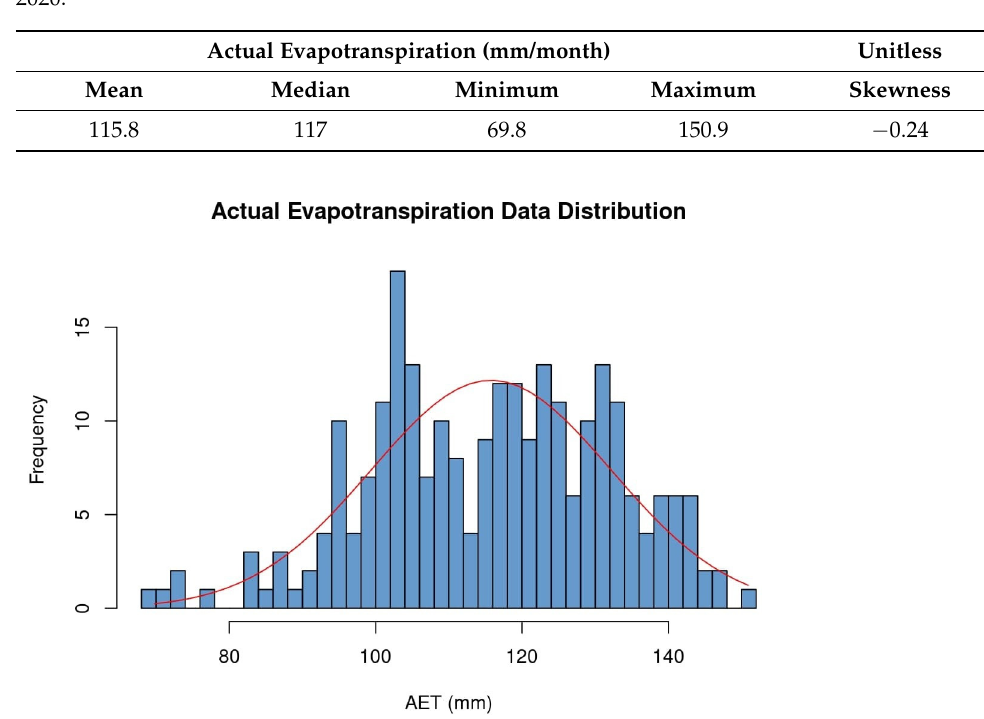
Table 2. Descriptive statistical estimates of actual evapotranspiration in Busia County for September